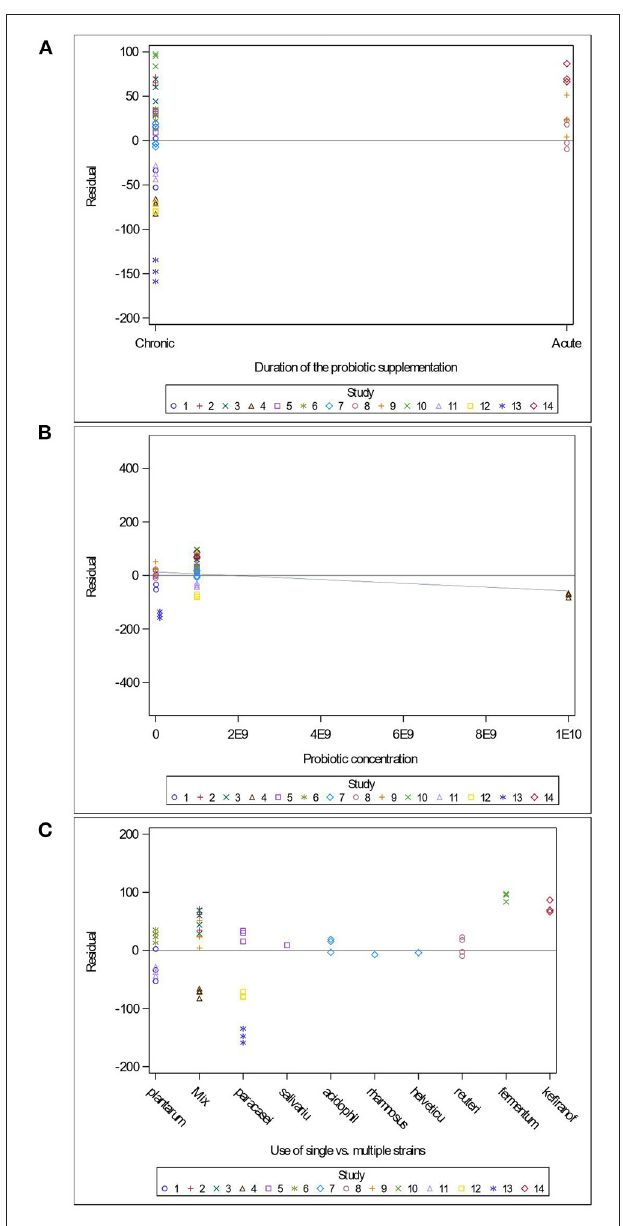
FIGURE 6 | Raw residuals of Model 3 (Supplementation*Stress) plotted against the duration of Lactobacillus -based probiotic supplementations (A) , probiotic concentration (B) and the use of single or combination of bacterial strains as probiotics (C) , where points represent treatment means and are coded by study.